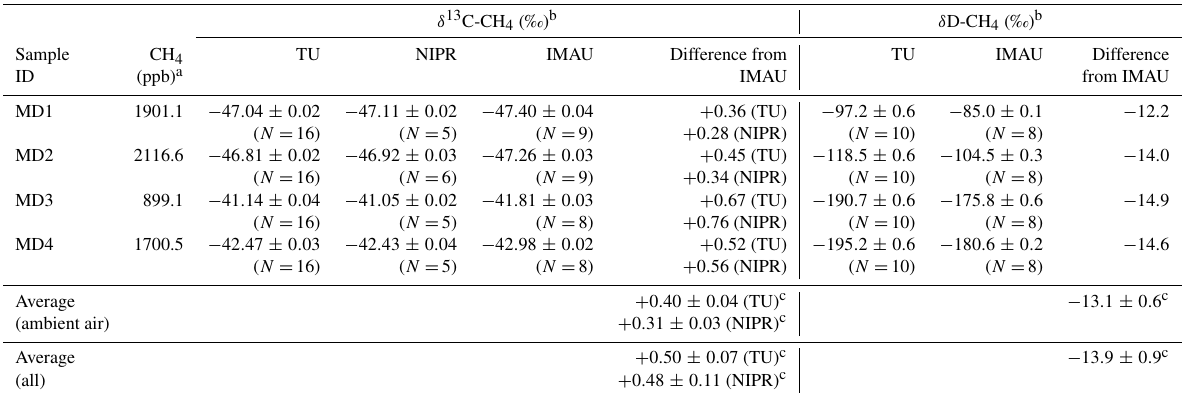
Table 3. Result of intercomparison of δ 13 C-CH 4 and δ D-CH 4 measurements between TU/NIPR and